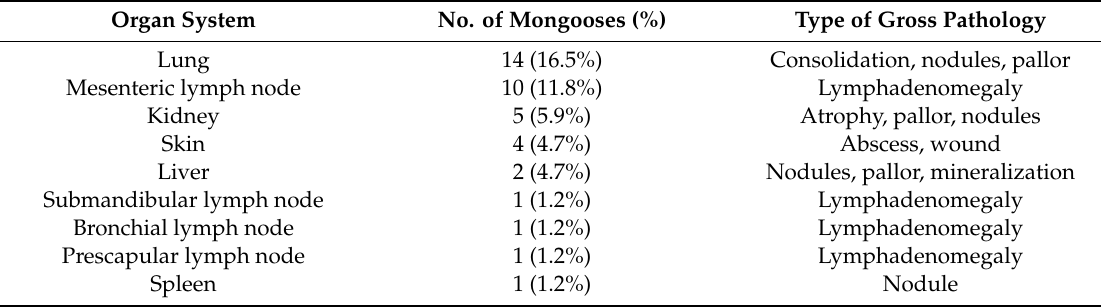
Table 1. Prevalence of gross pathological lesions among 85 wild caught mongooses that were trapped on M. bovis a ff ected dairy farms in Fiji during January–February 2017. Data for individual mongooses are provided in Table S1.